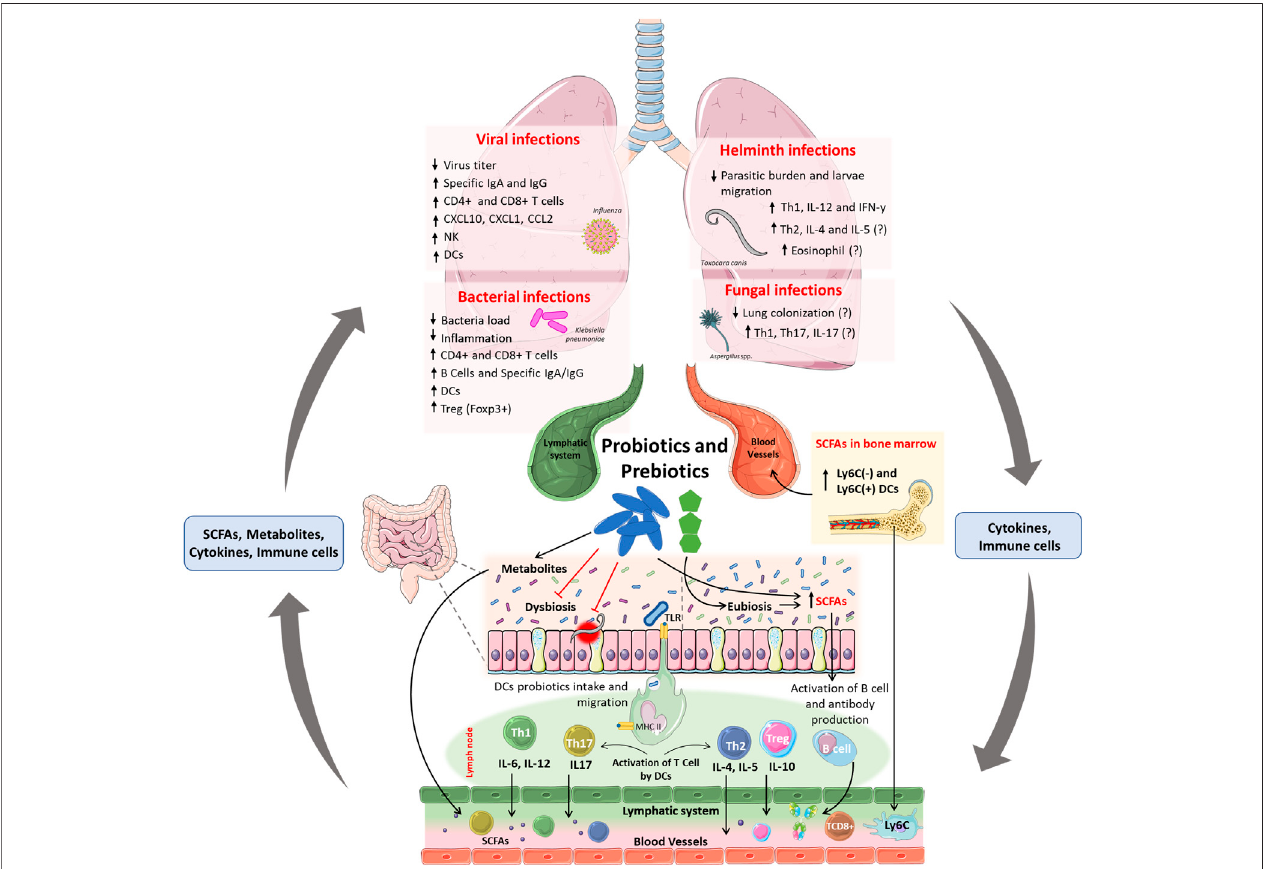
FIGURE 2 | Effects and mainly mechanisms of probiotics and prebiotics in the gut-lung axis and context of respiratory infections. Probiotics and prebiotics administered orally can improve dysbiosis and induce eubiosis in the host, leading to an increase in SCFAs directly (produced by probiotics) or indirectly (produced by commensal microbiota). Furthermore, probiotics can also reduce the burden and epithelial damage induced by intestinal parasites. The uptake of probiotics by DCs in the intestinal submucosa, and their migration to lymph nodes, induces the activation and proliferation of Th1, Th2, Th17, Treg, and B cells. Activated T cells and B cells produce cytokines and antibodies, enter the circulatory and lymphatic systems, and reach the lungs, where they will increase resistance to infections caused by viruses, bacteria, and fungi. The fermentation of prebiotics and production of SCFAs increases the number of DCs precursors in the bone marrow and increases CD8 + T cells activity, that confer protection against infections in the lung. The immunomodulation demonstrated after the administration of probiotics and prebiotics may be linked to the reduced viral titer, bacterial colonization, parasite load, and migration in the lungs. Probiotic-induced immunomodulation can increase the frequency of dendritic cells and CD4 + and CD8 + T cells in the lungs against infections by viruses and bacteria and can increase speci fi c IgG and IgM antibodies to these pathogens. Also, the increase in Treg cells may be related to the reduction of in fl ammation-induced lung damage. In parasitic infections, probiotics have been linked with increased frequencyofTh1andconcentrationofIL-12andIFN- γ ,whichmayjustifythereductionintheparasiteloadandlarvaemigrationinthelung.Becausetherearenoscienti fi c studies that demonstrate the reduction of lung colonization by fungi after oral administration of probiotics, is still unknow if the antimycotic potential from probiotics metabolites, as shown in vitro , could be applied in an in vivo system.